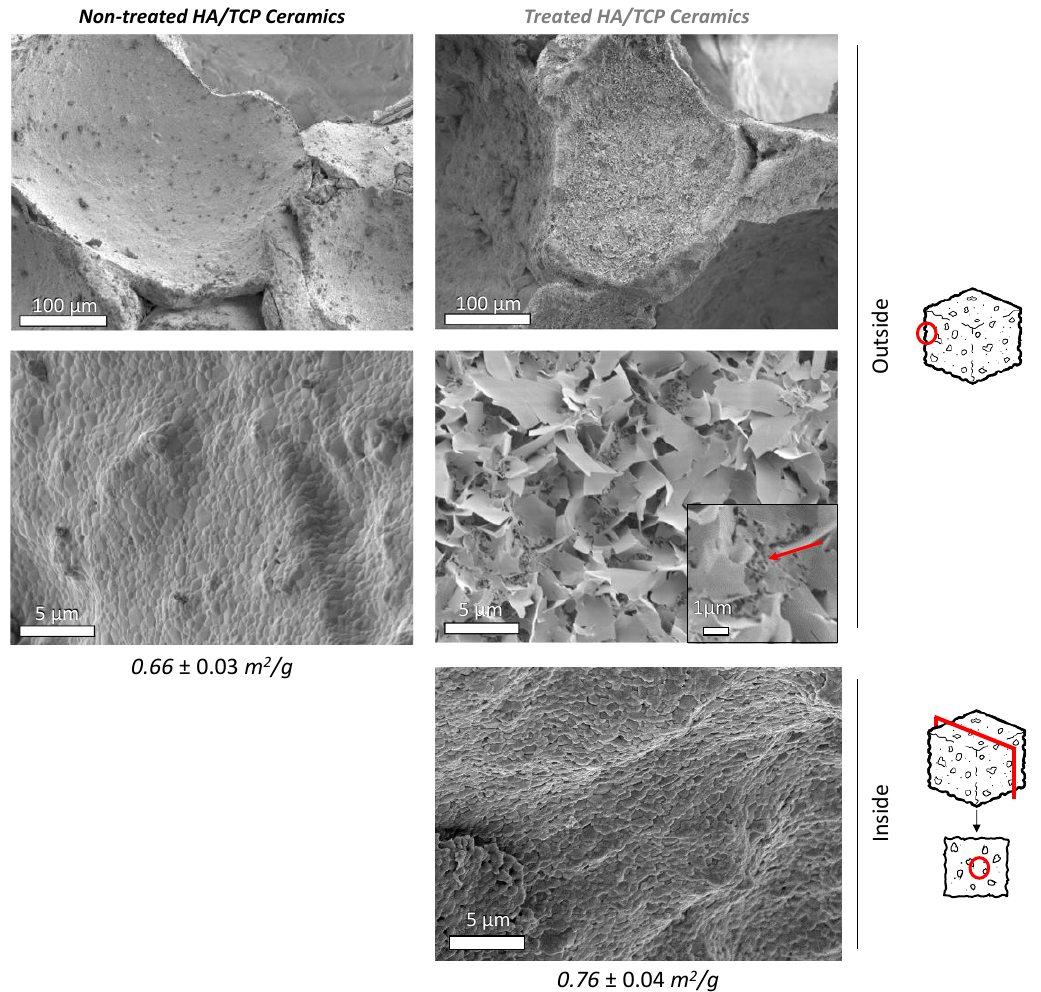
Figure 3. SEM pictures of non-treated and treated (4 h, 37 ◦ C, 80 bar pressure, L/S = 2) HA/ β -TCP ceramic scaffolds and corresponding specific surface area (Krypton BET). Smaller particle sizes around 0.5 µm may be seen on the outer part, with deeper porosity (red arrow).